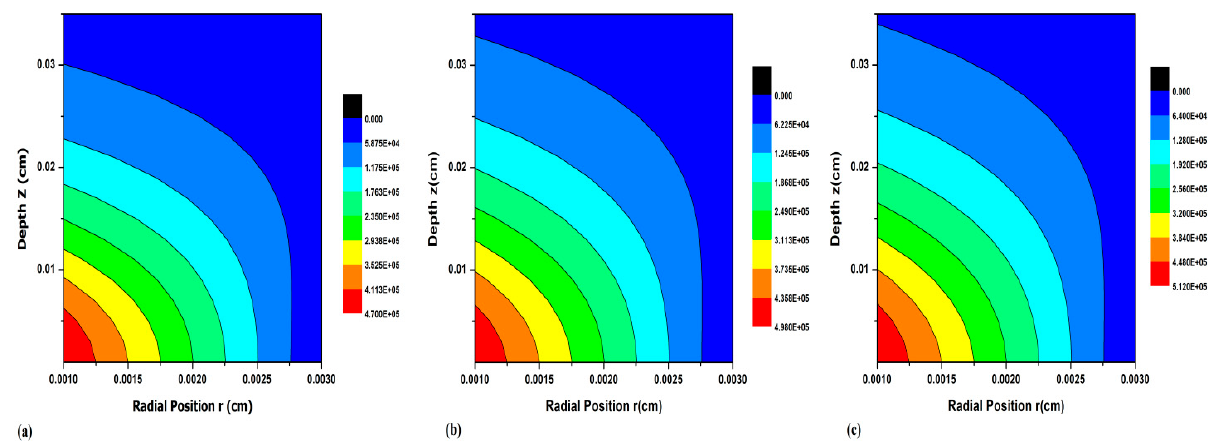
Figure 6. Photon distribution representation as a function of depth (z) and radial position (r) at 800 nm for ( a ) pristine UHMWPE ( b ) 30 kGy irradiated UHMWPE, and ( c ) 100 kGy irradiated UHMWPE.